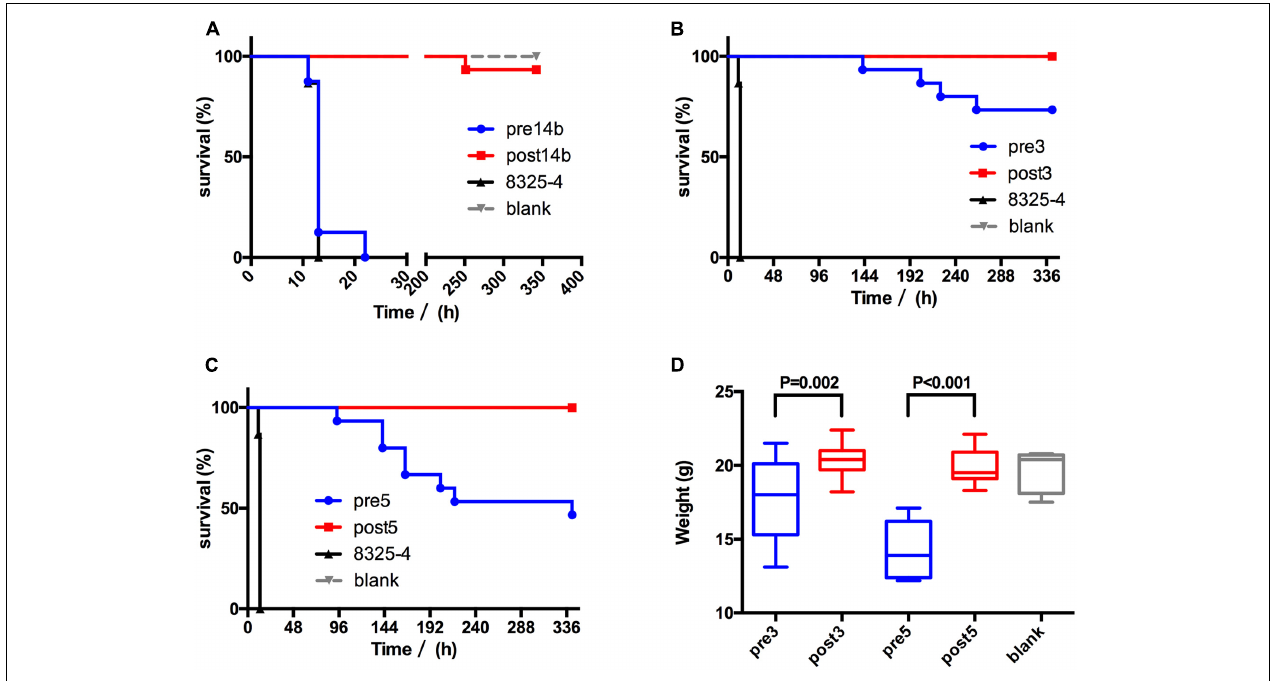
FIGURE 2 | Pathogenicity and lethality ability of S. aureus in mice. The survival curves of (A) Pre14b/Post14b, (B) Pre3/Post3, and (C) Pre5/Post5 are shown. S. aureus 8325-4 was used as high toxicity control, and 1 × PBS was used as blank control. (D) The body weight of surviving mice after infection with Pre3/Post3 and Pre5/Post5. Mice infected by 1 × PBS were used as a blank control.